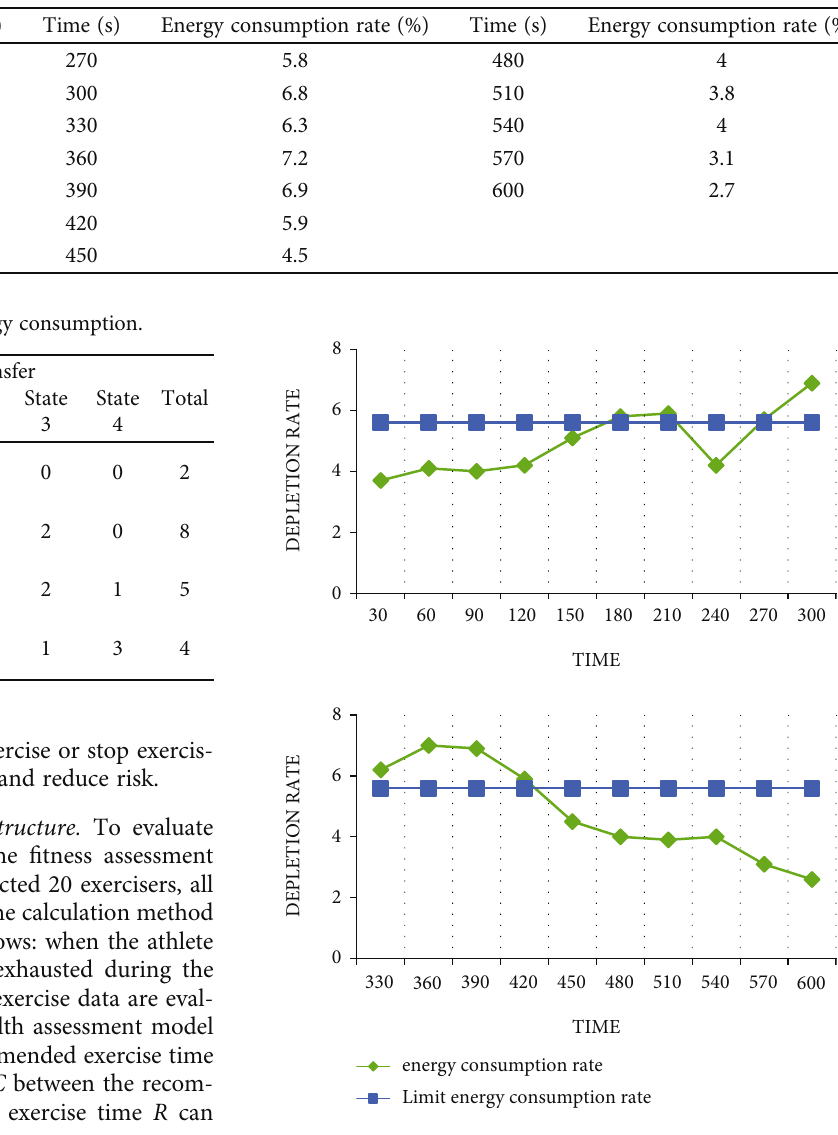
Table 3: Energy expenditure rates of sports dance athletes exercising for 10 minutes continuously.